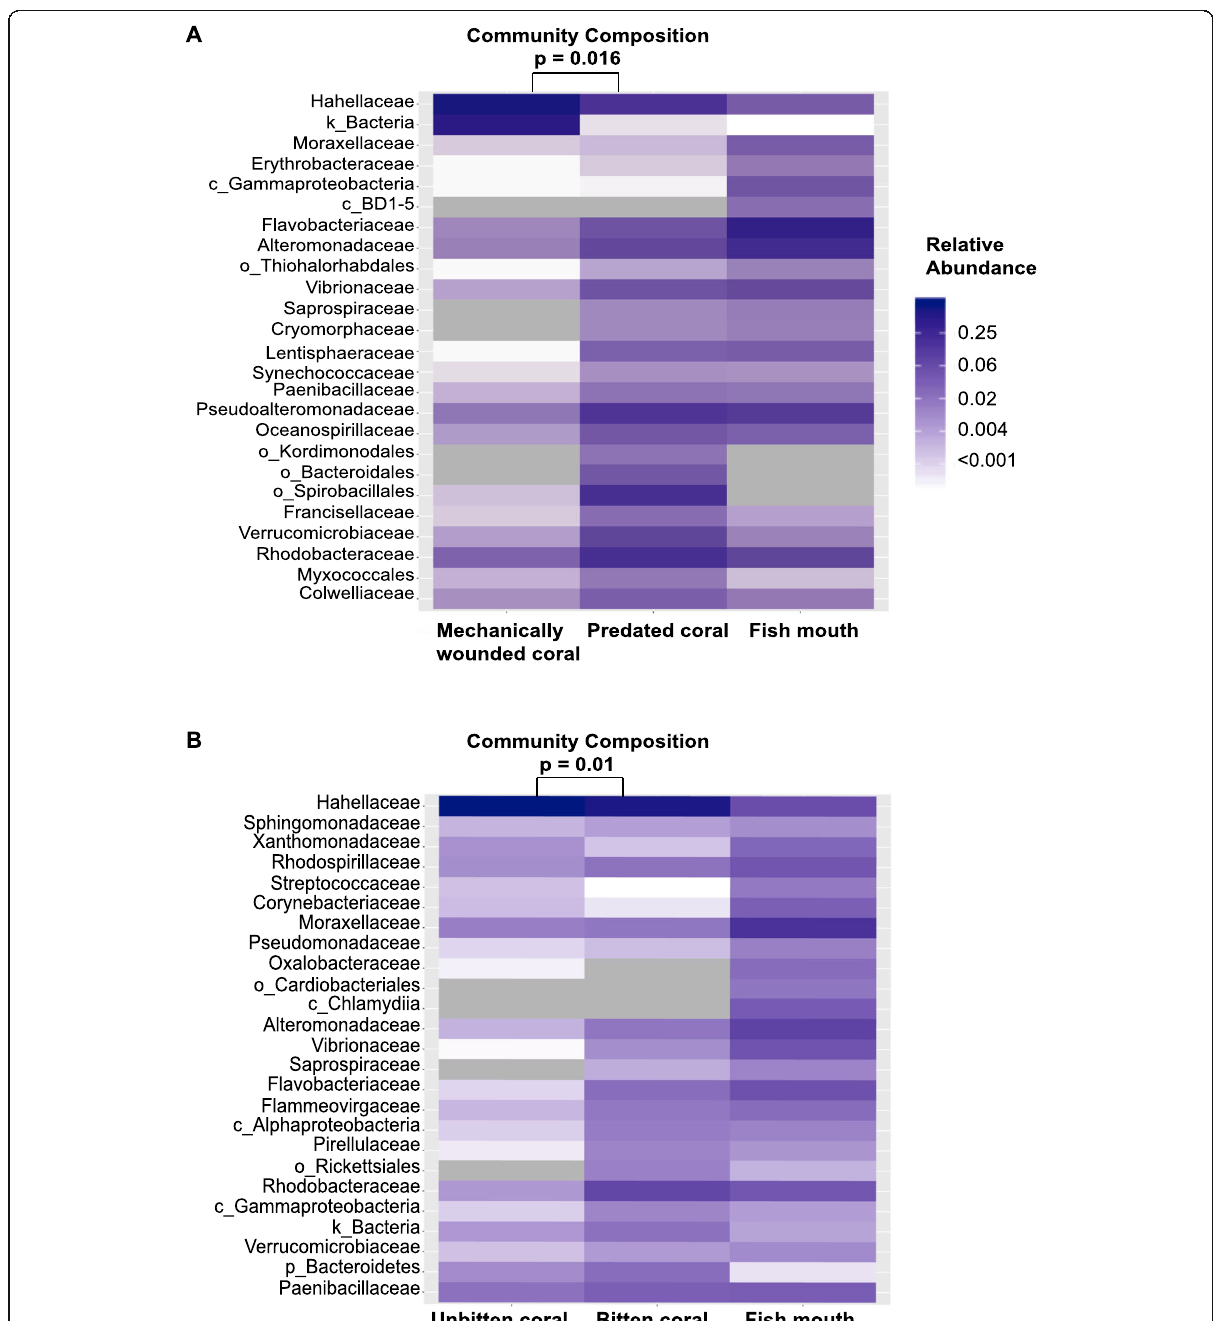
(Fig. 2; Additional file 1: Tables S4 and S5). Distinct community assemblages were also observed between parrotfish mouths and predated corals at Ti (Fig. 2; Add- itional file 1: Tables S1 and S2; pairwise Adonis; p = 0.003) and at T (pairwise Adonis, p = 0.012). Among the f